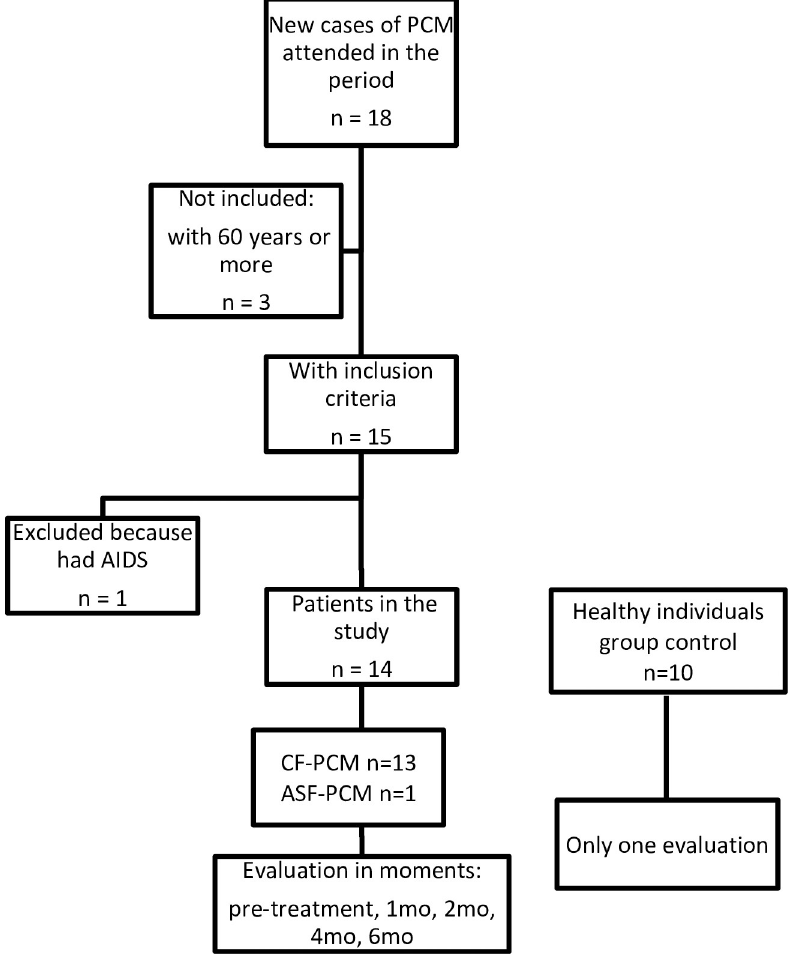
Fig 1. Flow diagram of participant selection and study design. Mo = months; CF-PCM-: chronic form of PCM; ASF-PCM: acute-subacute form of